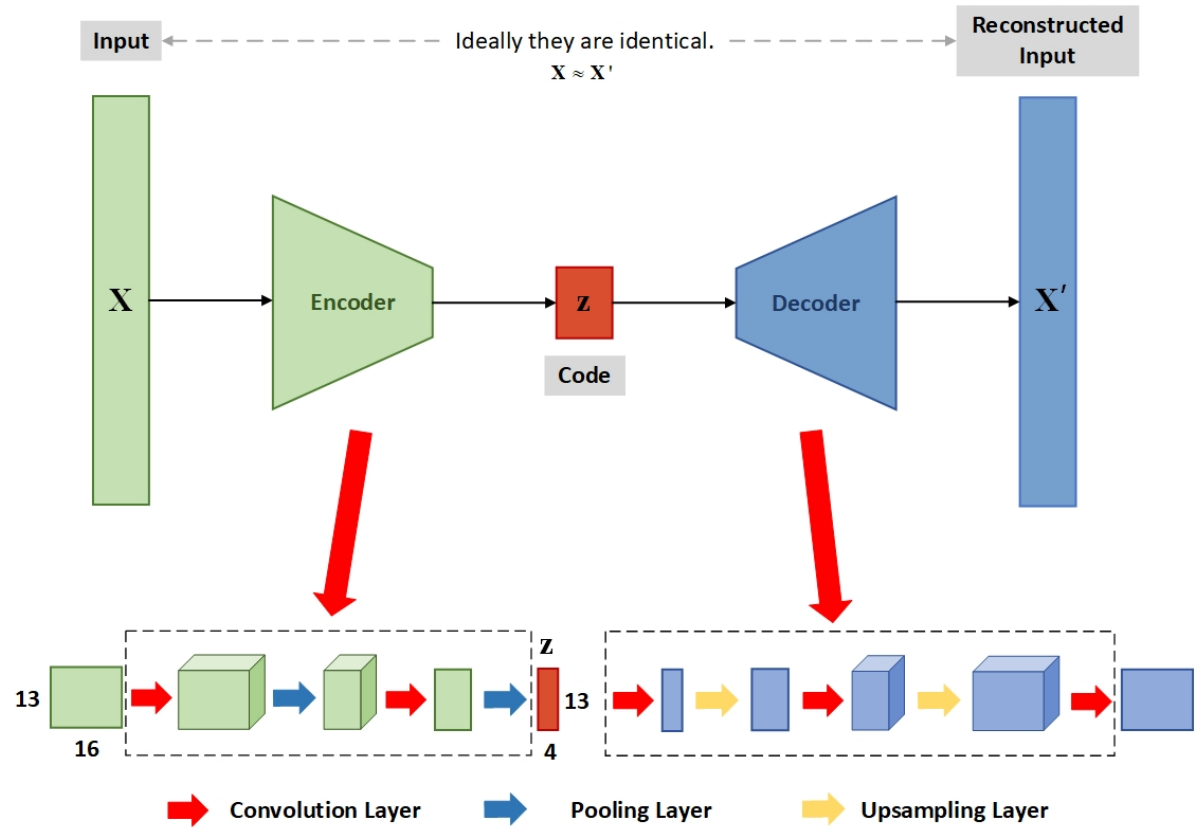
Figure 7. An autoencoder based on a CNN.